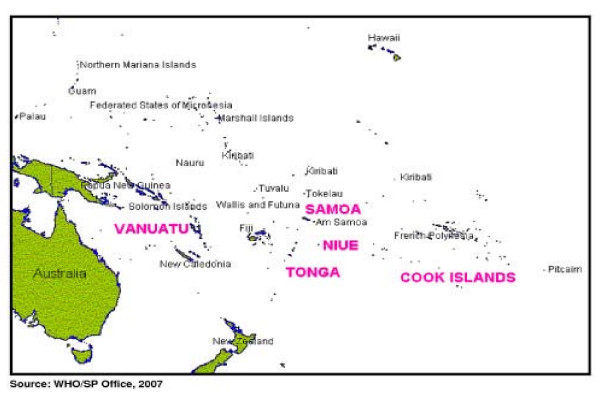
Map of the Pacific Region, highlighting case study countries.